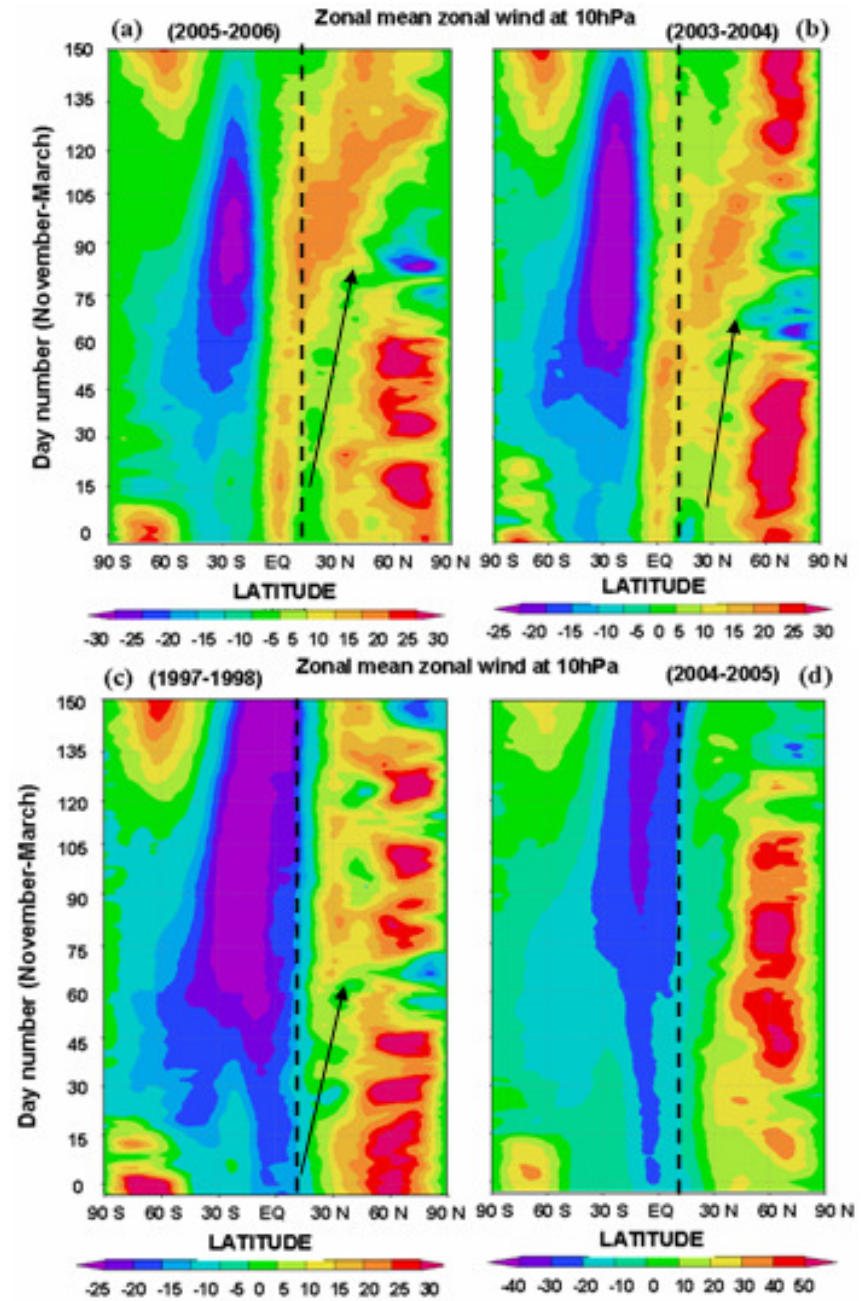
Fig. 2. The zonal mean zonal wind around the globe during the period 1 November–31 March, for the SSW years (a) (2005–2006), (b) (2003– 2004), (c) (1997–1998) and a non-SSW year (d) (2004–2005). The location of Trivandrum is shown using dotted lines and zero wind line is marked using arrows. Positive wind is